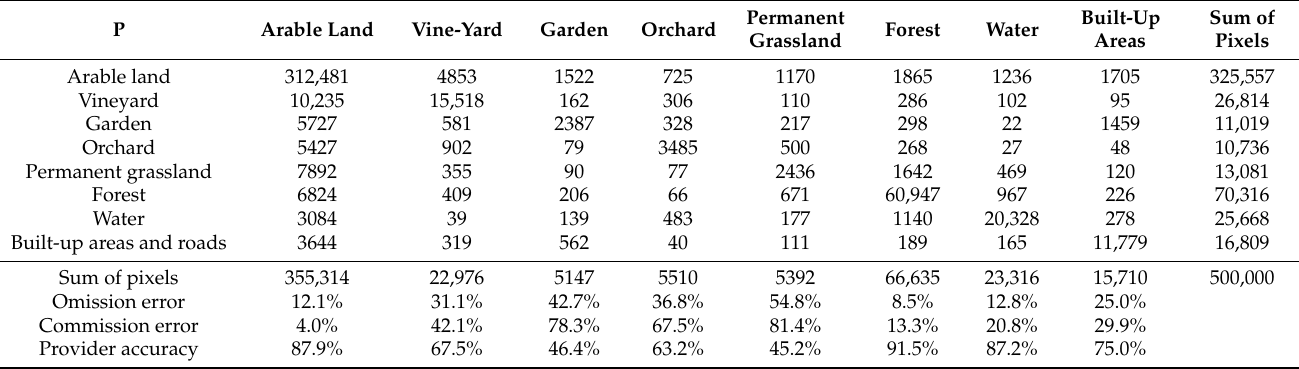
Table 3. Confusion matrix of the LULC (land use/land cover) classification experiment in the southern part of the South Moravian region. The achieved overall accuracy (OA) was 85.9%. P